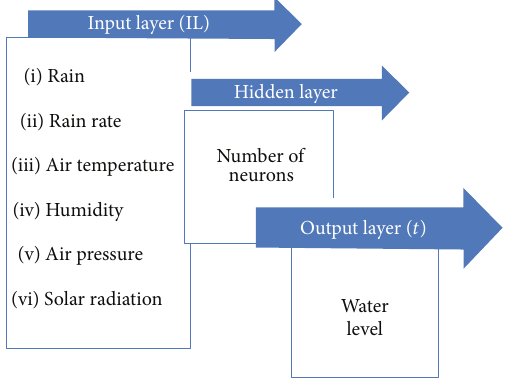
Figure 9: Schematized ANN model